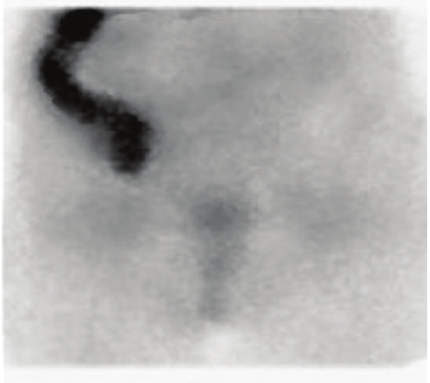
Figure 3: After the use of laxatives, the gallium-67 diffuse uptake of the ascending colon not only remained stable but rather strength- ened without any topographic change at the repeated 72-hour imaging, indicating active inflammation.